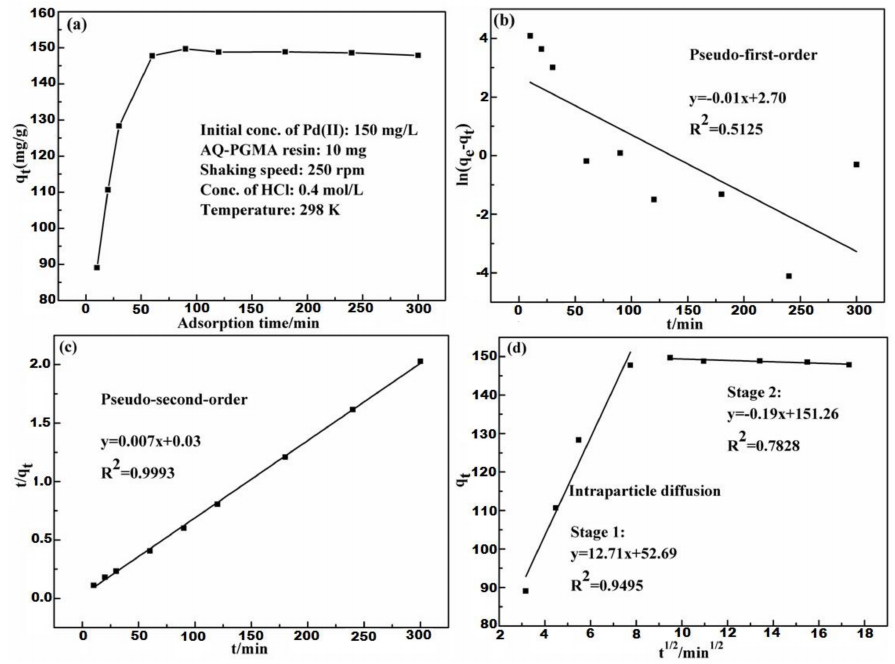
Figure 4. Effect of adsorption time on the adsorption of Pd(II) by AQ-PGMA ( a ) and kinetic models (Pseudo-first-order ( b ), Pseudo-second-order ( c ), Intra-particle diffusion ( d